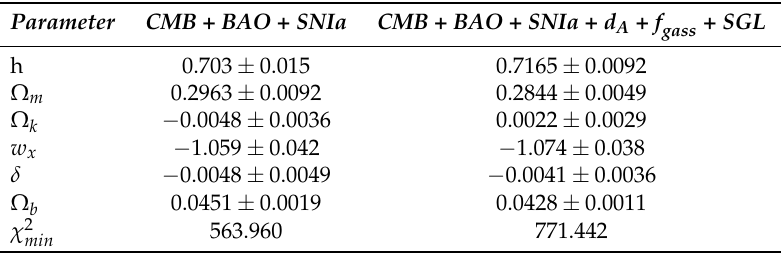
Table 4. Summary of the best fit values for the IDE model.